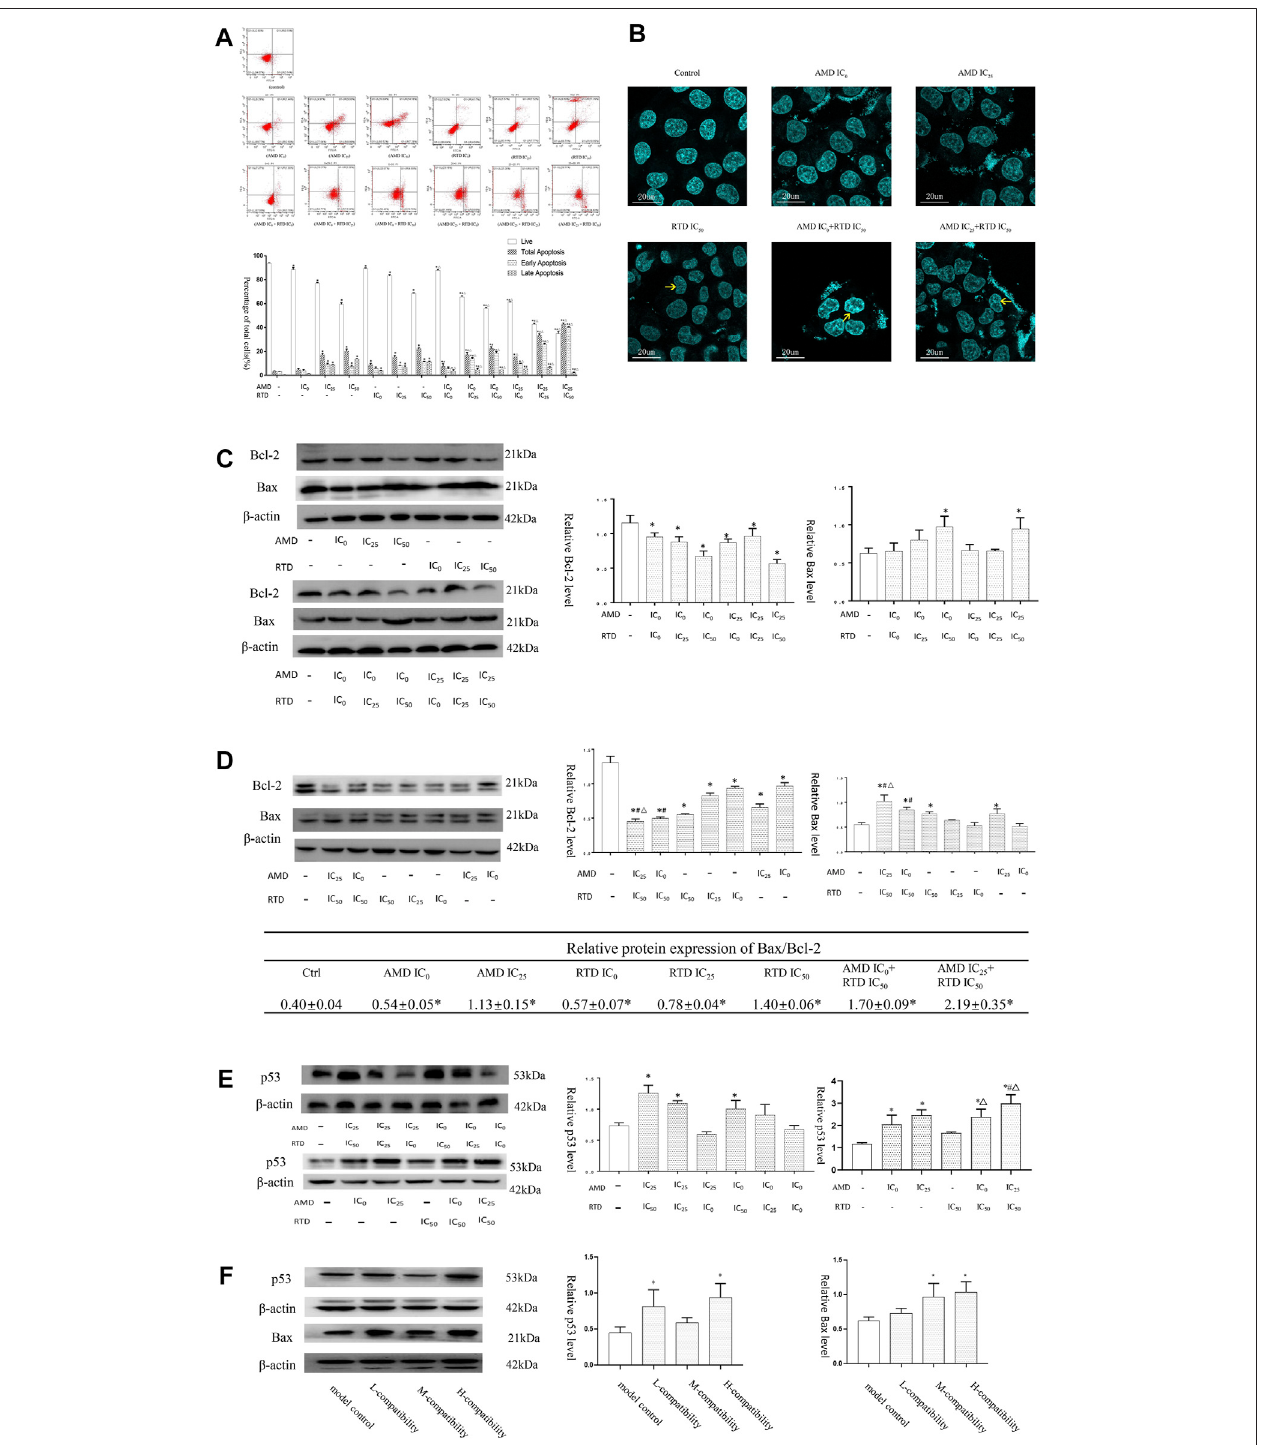
FIGURE6| AMD,RTD,andtheircompatibilitypromotedMMapoptosis. (A – B) EffectsofAMD,RTD,andtheircompatibilityonA375cellapoptosis. (C – D) Western blot analysis and relative quanti fi cation levels of Bcl-2 and Bax expression with herb treatment for 48 h (C) and 72 h (D) of A375 cells. (E) Western blot analysis and relativequanti fi cationlevelsofp53expressionofA375cellswithherbtreatmentfor72 h. n =3. p p < 0.05,comparedwiththecontrolgroup. # p < 0.05,comparedwiththe corresponding AMD group. △ p < 0.05, compared with the corresponding RTD group. (F) Western blot analysis and relative quanti fi cation levels of p53 and Bax expression of the mice tumors. p p < 0.05, compared with MCG.